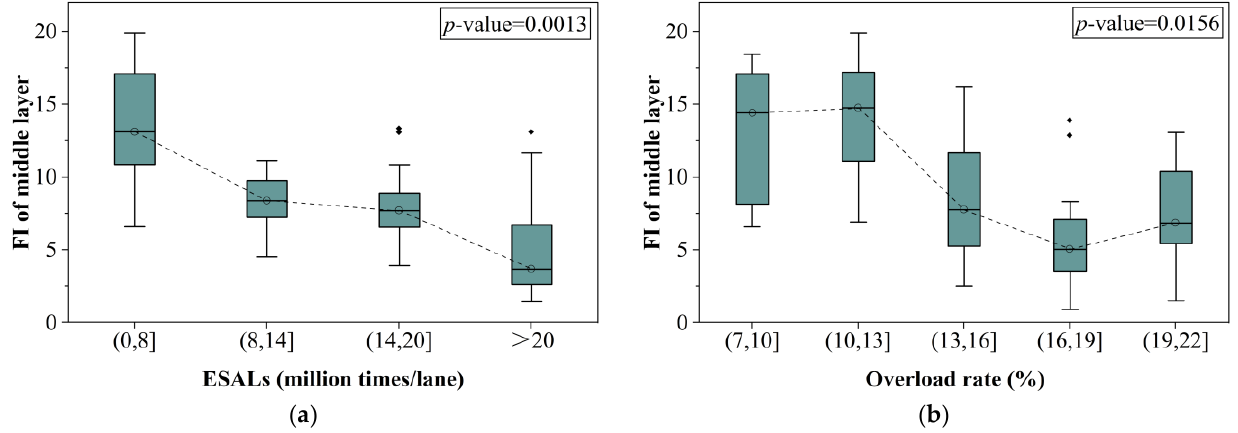
Figure 11. Relationship between FI and significant factors for the middle layer: ( a ) FI versus ESALs and ( b ) FI versus overload rate.